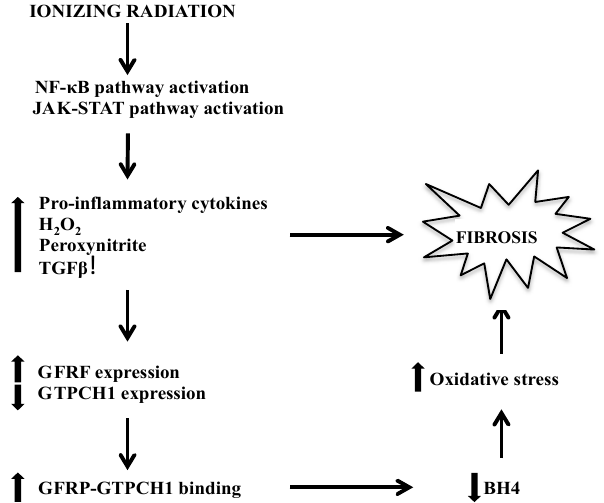
Figure 1. Major pathways by which BH4 deficiency-mediated fibrosis manifests following IR. BH4, tetrahydrobiopterin; IR, Ionizing